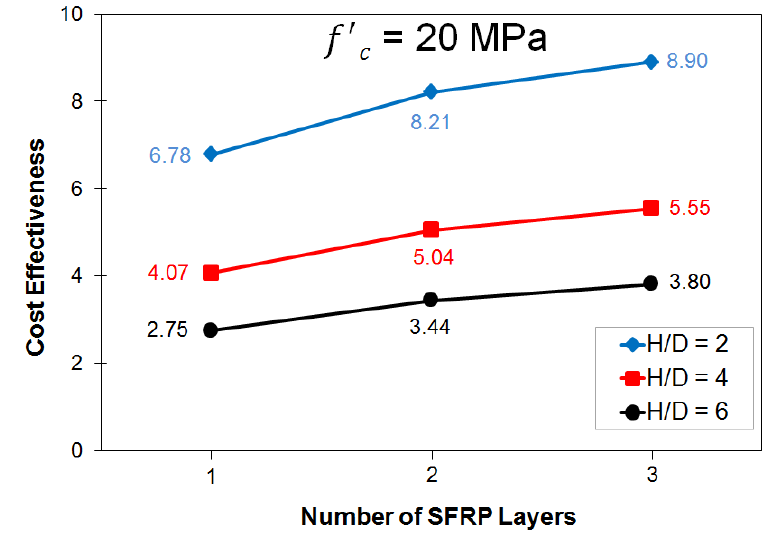
Figure 9. Cost effectiveness of SFRP confined concrete columns with 20 MPa concrete strengths and varying numbers of SFRP layers and slenderness ratios.